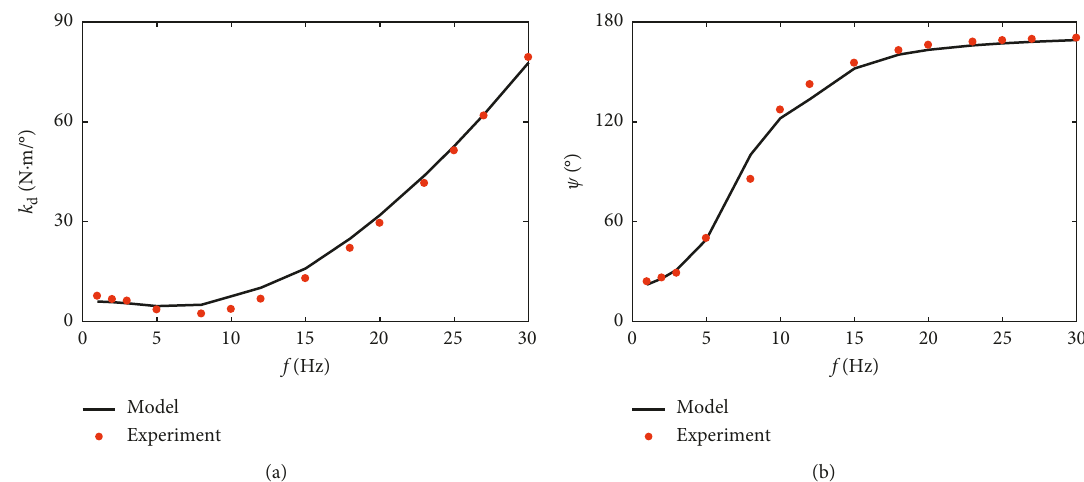
Figure 14: Excitation amplitude θ